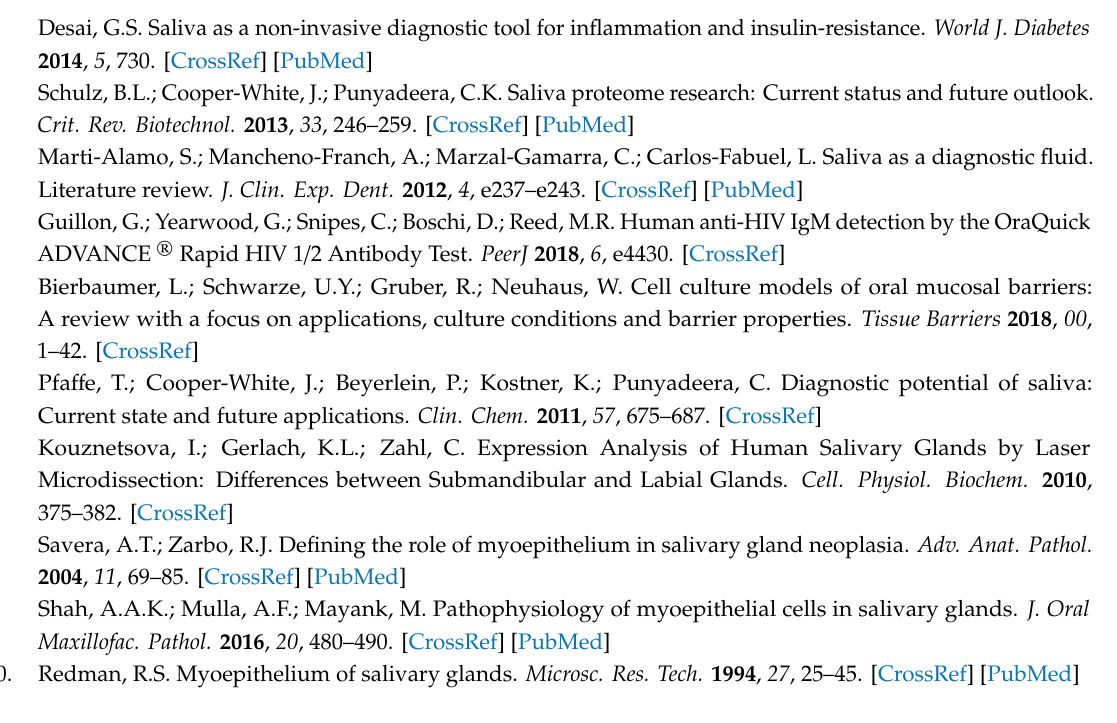
Figure S1: Hematoxylin–Eosin staining (HE) of HTB-41 upon cultivation under airlift and submerged conditions on 24-well Transwell ® inserts; Figure S2: TEER values [ Ω × cm 2 ] over time of clone B2 as mean ± SEM under submerged condition, supplemented with 100 nM hydrocortisone (HC) and 10 µ M retinoic acid (RA); Figure S3: Agarose gels after quantitative real-time PCR showing the tested markers of HTB-41 and Clone B2, B4, B9, D3 and F11 applied against a 50 bp ladder; Figure S4: Results of flow cytometry of parental HTB-41 and clone B2 cells; Figure S5. Expression of the transferrin receptor (TfR) at the mRNA level of the salivary gland model based on clone B2 and of the oral mucosa model based on TR146 cells; Table S1: Primer sequences of applied markers for qPCR; Table S2: Solutions used for immunofluorescence staining; Table S3: Statistical analysis of qPCR results of cell-type specific markers of isolated clones B2, B4, B9, D3, and F11 normalized to parental HTB-41; Table S4: Solutions used for flow cytometry with the applied dilution in 50 µ L cell